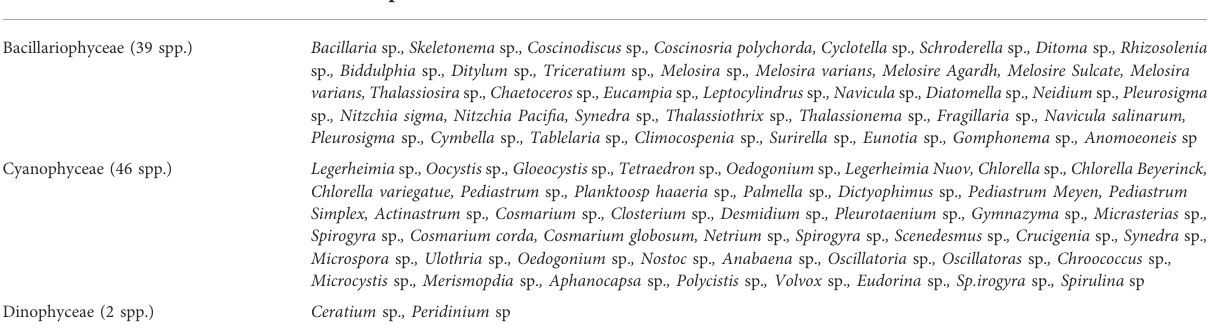
TABLE 4 Diversity of phytoplankton (87 spp.) in the estuarine waters of Bangladesh. Class Genus/Species Bacillariophyceae (39